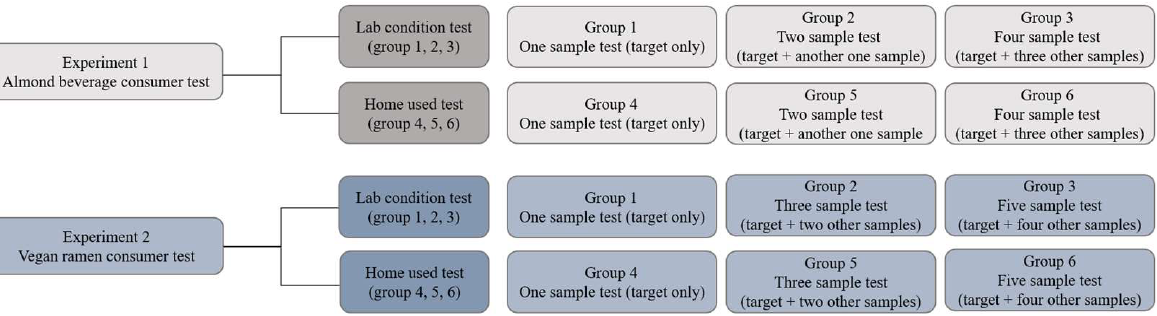
Figure 1. Overall experimental design.